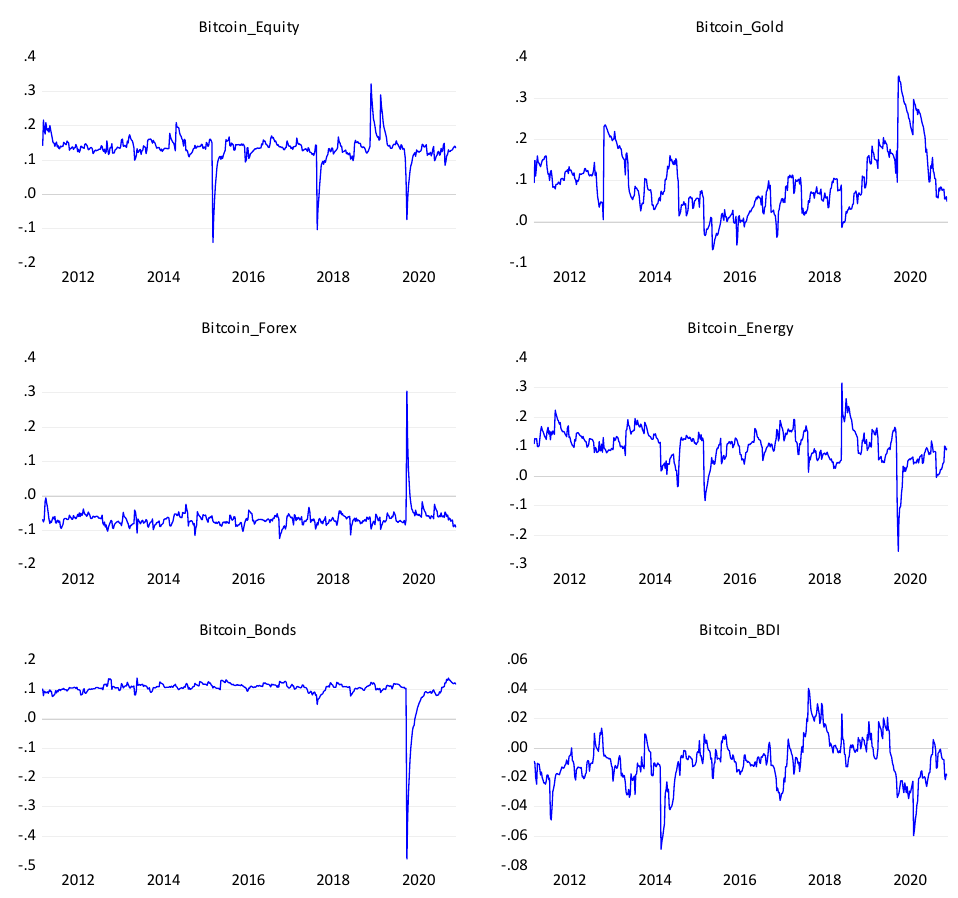
Figure 3. Dynamic conditional correlation graphs (DCC-GARCH).